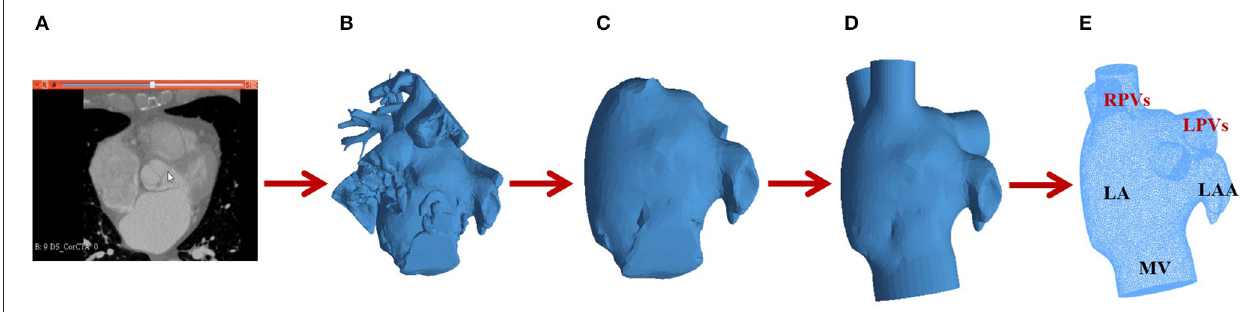
FIGURE 4 | Mesh processing pipeline for hemodynamics simulations: (A) Computed Tomography (CT) image; (B) Surface mesh after CT segmentation; (C) Removal of structures surrounding the left atrium (LA); (D) Insertion of cylinders for the pulmonary veins (PV); (E) Volumetric LA mesh with two right pulmonary veins (RPVs), two left pulmonary veins (LPVs), a mitral valve (MV) and the left atrial appendage